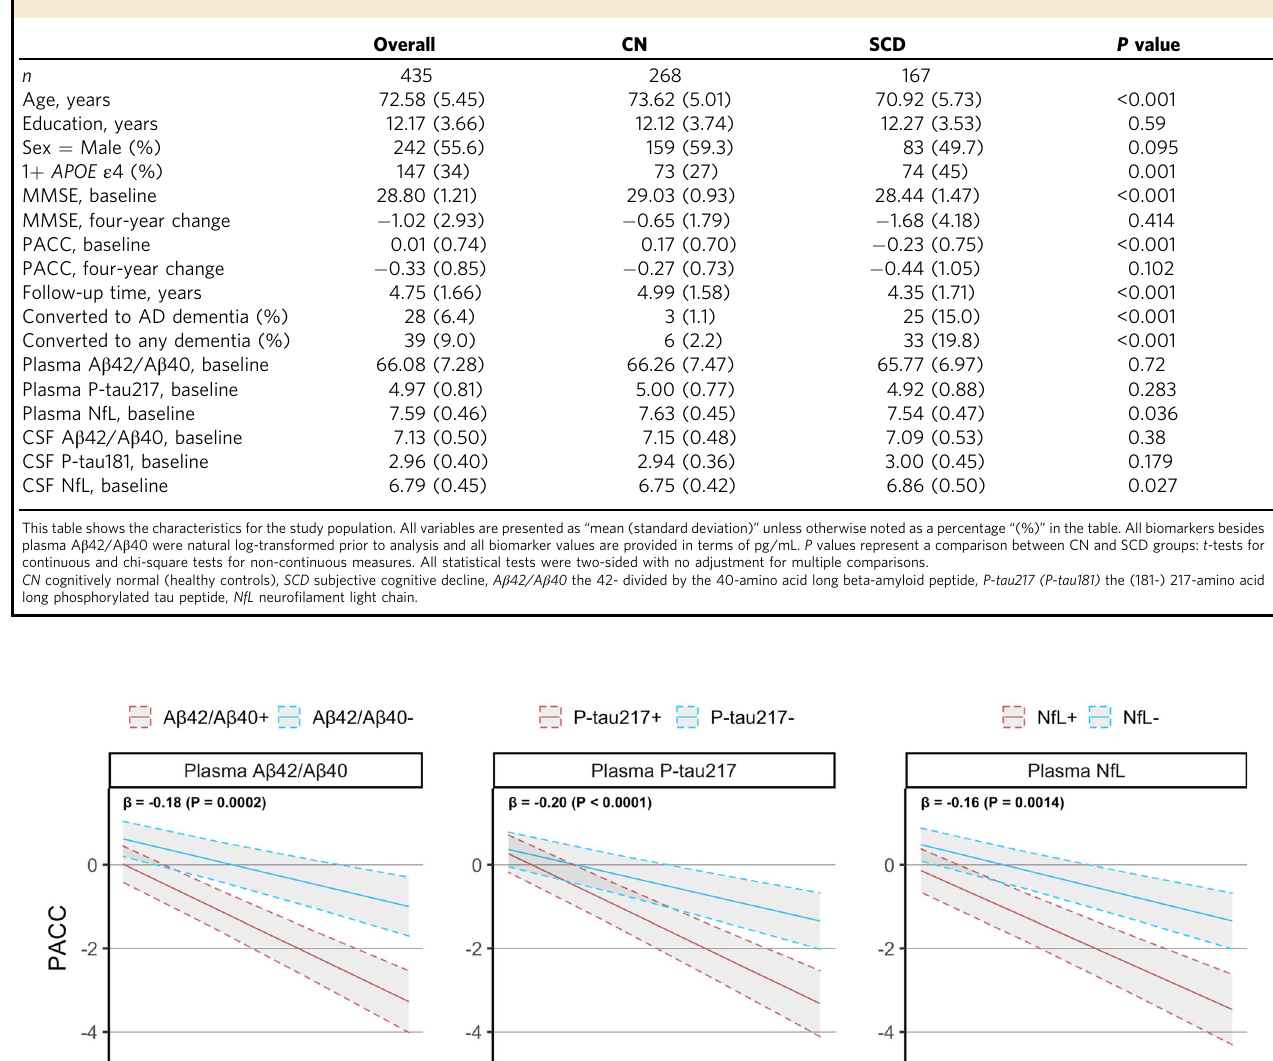
Table 1 Study participant characteristics.